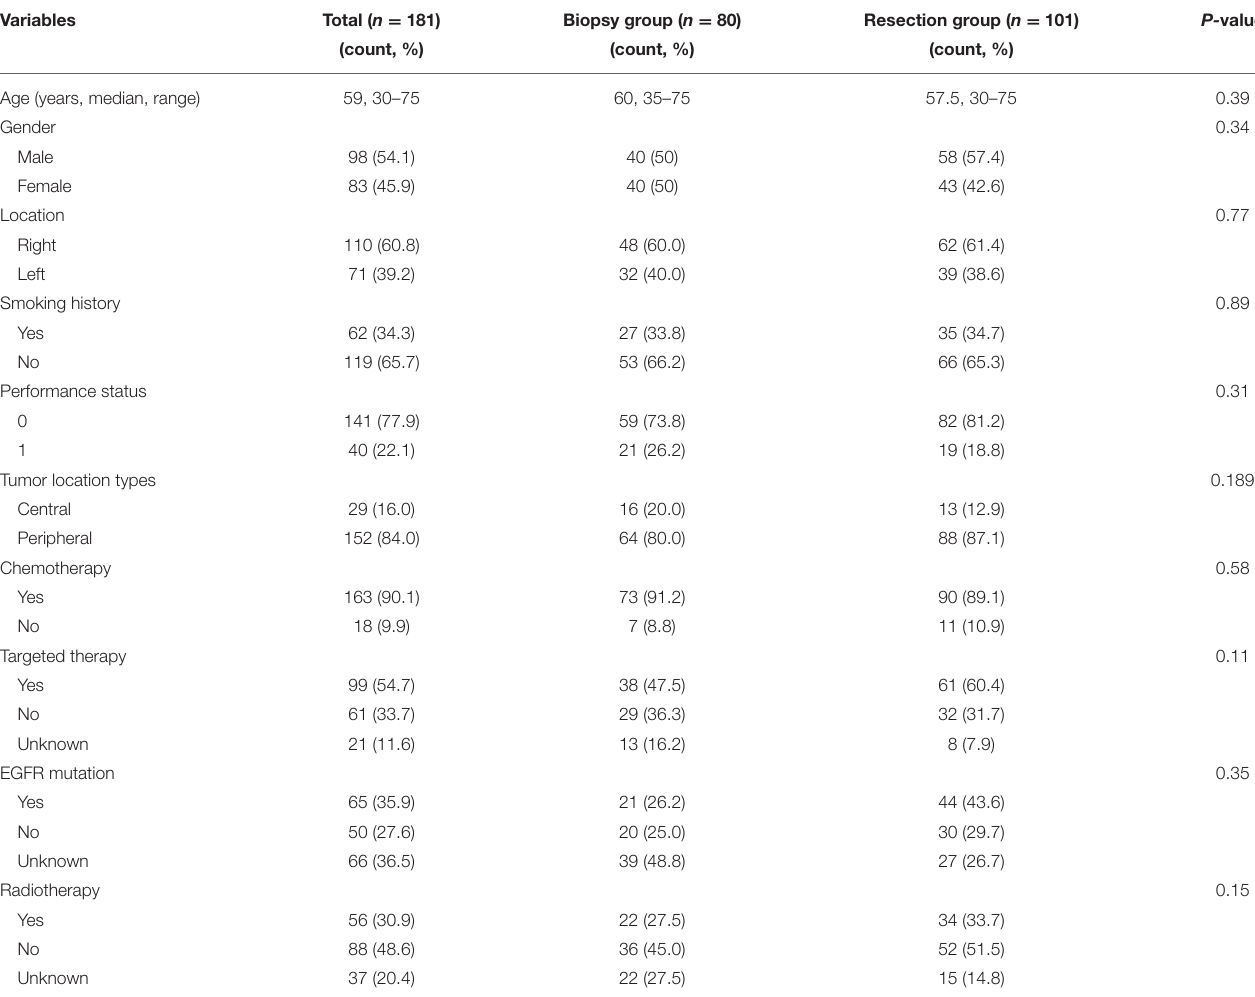
TABLE 1 | Baseline clinical features of pleural biopsy group and primary tumor resection group.